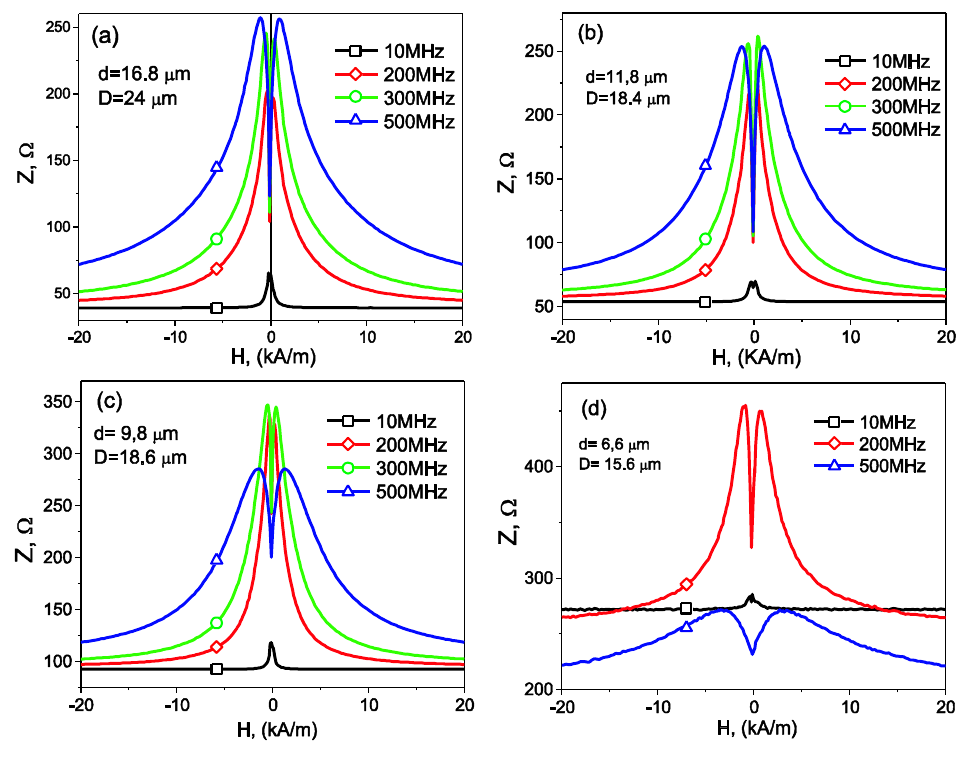
Figure 8. Z(H) dependence Co geometry